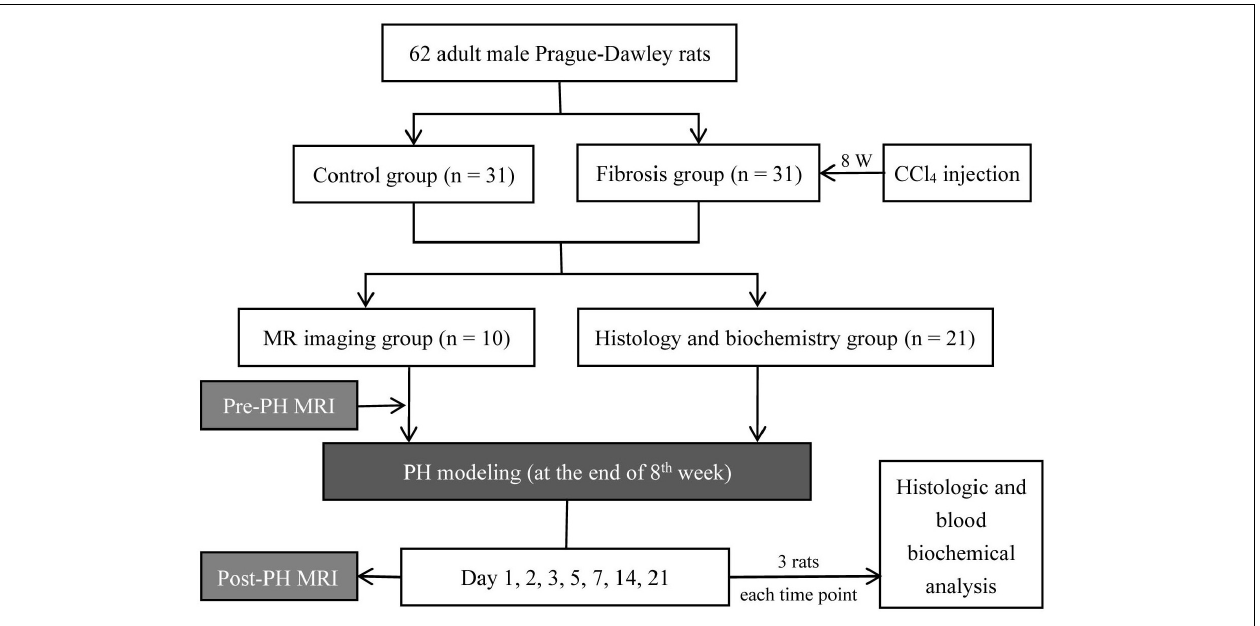
FIGURE 1 | Flowchart of the experimental procedure; PH, partial